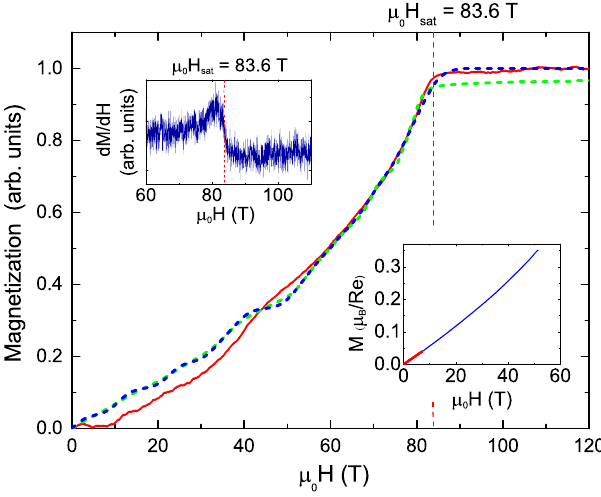
Fig. 5 | Magnetization of a CROC. Magnetization of a CROC powder sample in magnetic fi elds up to 120T, obtained using a pulsed single-turn magnet (red line; the initial temperature is 5K) together with results of OFTLM calculations for a triangular-lattice AF with J / k B =41.7K, J 0 = J =0 : 25 in isothermal (blue dashed line) and adiabatic (green dashed line) approximations 23 . The left inset shows the deri- vative of the as-measured magnetization M ; the saturation fi eld μ 0 H sat =83.6 T is determined as shown. The right inset shows the magnetization of a CROC powder sampleinmagnetic fi eldsupto51Tmeasuredusinganon-destructivemagnet(the initialtemperatureis1.3K).Magnetizationofapowdersampleatatemperatureof2 K in DC fi elds up to 7T is shown in red.